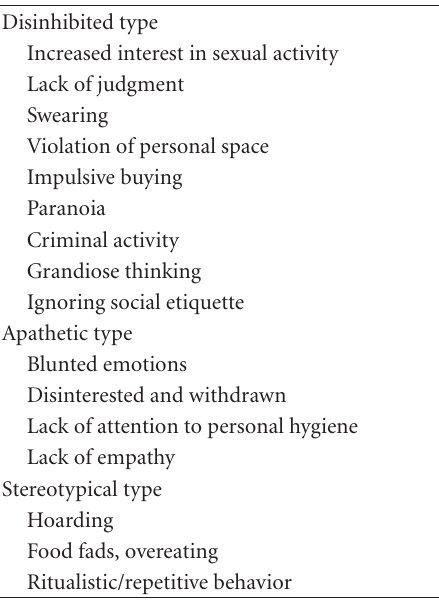
Table 1: Behavioral features in FTLD [23,